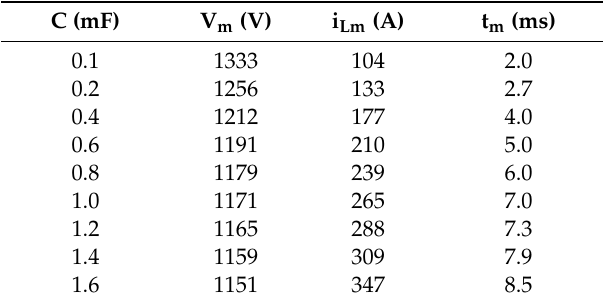
Table 2. Relationship between V m , i Lm , t m and C.